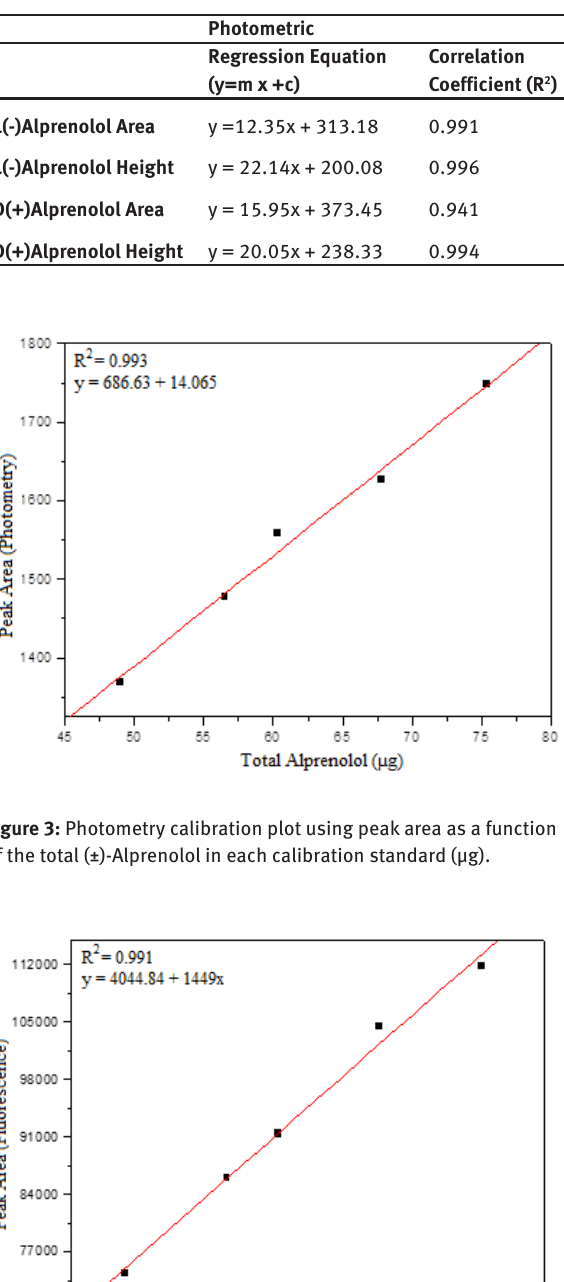
Table 1: Calibration data for L (-) Alprenolol and D (+) Alprenolol (N =